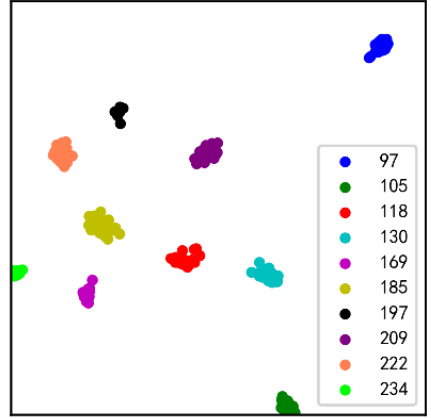
Figure 16. Visualization results of the LEG Transformer.